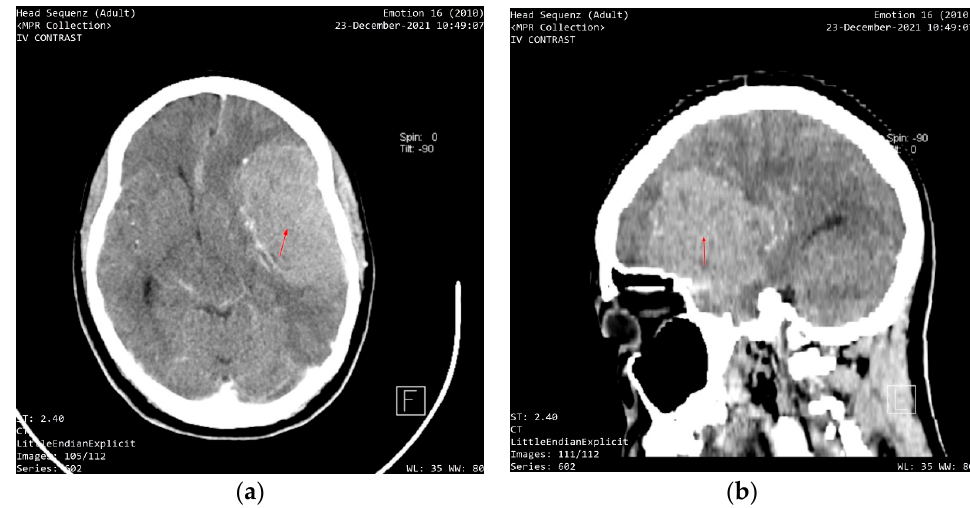
Figure 2. ( a ) An axial section showing a contrast image depicting a well-circumscribed, homogenous mass compressing the left frontal lobe; ( b ) A sagittal section shows a contrast image depicting an intracranial mass.